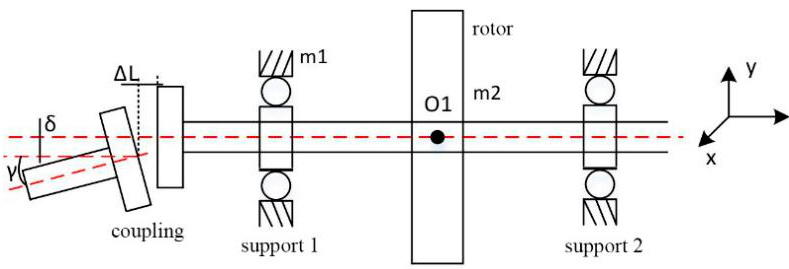
Figure 1. Dynamic model of range extender.